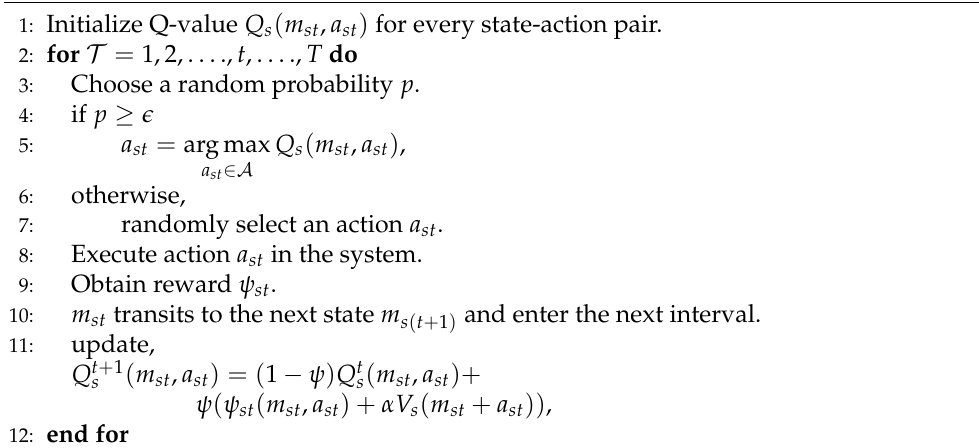
Algorithm 1 Q-Learning based Data Caching at SBS level.